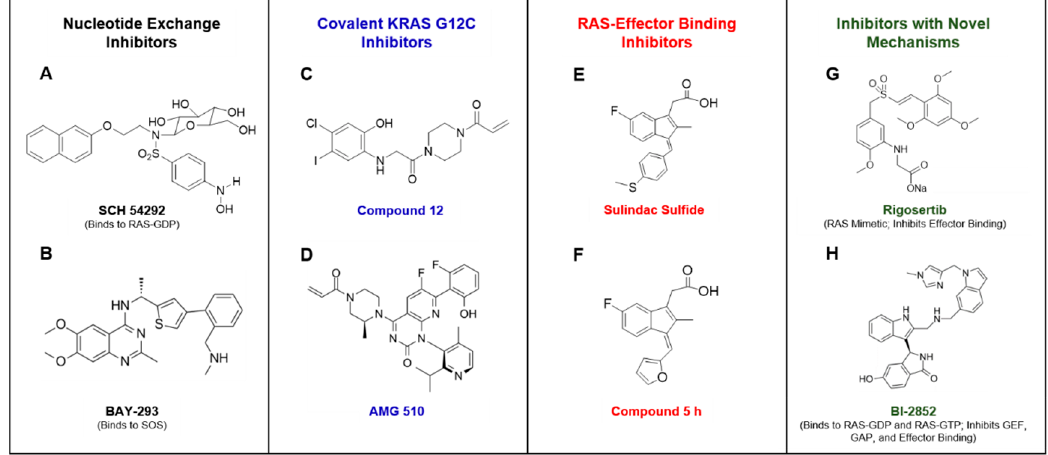
Figure 3. Portrays compounds that have been reported to inhibit RAS or RAS signaling by various mechanisms. SCH 54292 was reported to bind GDP-bound RAS and inhibit nucleotide exchange [41] ( A ). BAY-293 was found to directly bind to SOS and inhibit RAS nucleotide exchange [45] ( B ). Compound 12 was the first covalent KRAS G12C selective inhibitor to be identified [50] ( C ). AMG 510 is a covalent KRAS G12C inhibitor that is currently in clinical trials [55] ( D ). Sulindac sulfide has been reported to weakly bind to RAS and inhibit RAS-effector binding [67] ( E ). Compound 5 h is a sulindac derivative that was found to have improved RAS binding activity in comparison to the parent compound [74] ( F ). Rigosertib was described as a RAS mimetic that inhibits RAS-mediated activation of effectors [64] ( G ). BI-2852 was reported to bind to the switch I/II pocket of RAS-GDP and RAS-GTP to inhibit GEF, GAP, and effector binding to RAS [75] ( H ).